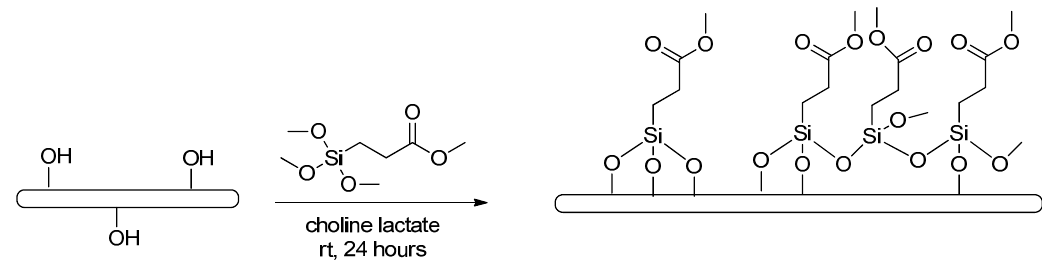
Scheme 1. Proposed scheme reaction for CNCs functionalization.